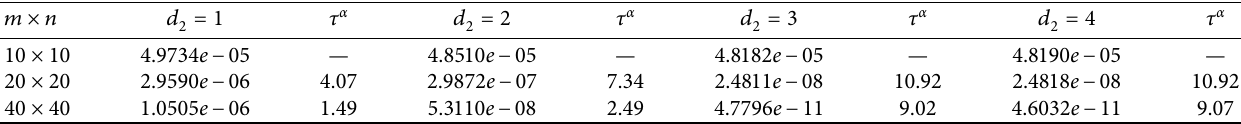
� 9 for Example 1. 1